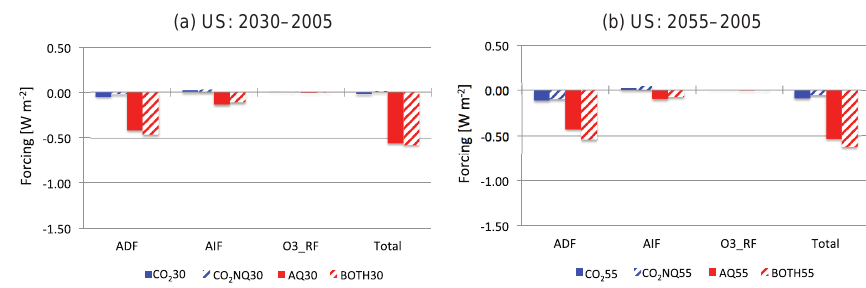
Figure 12. Same as Fig. 9 but for the difference in the US mean between ModelE2-TOMAS and